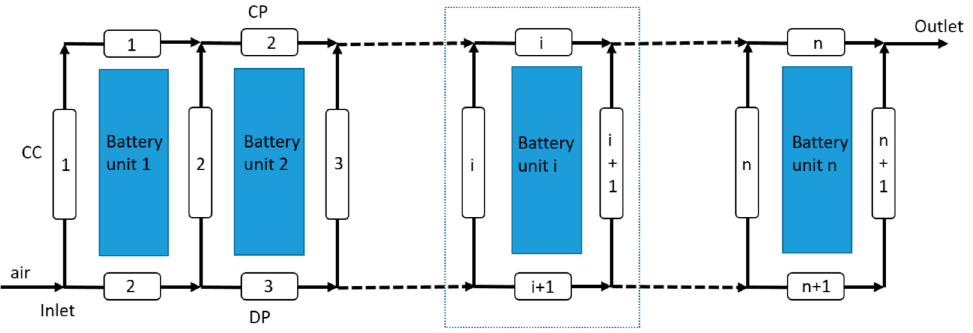
Figure 3. Schematic of the flow resistant